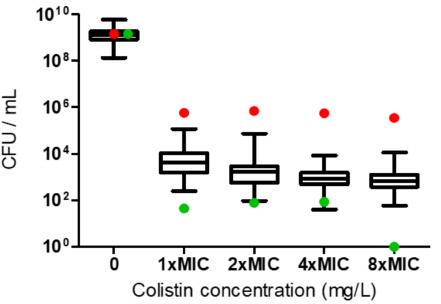
Figure 1. Heteroresistance (HR) determination according to population analysis profiling for the A. baumannii isolates. Growth of the 65 colistin-susceptible isolates at 8 × MIC indicated HR. The red dots represent the colistin-resistant control, and the green dots represent the colistin-susceptible non-HR control. Following exposure to colistin, eight isolates (12.3%) had a significantly higher